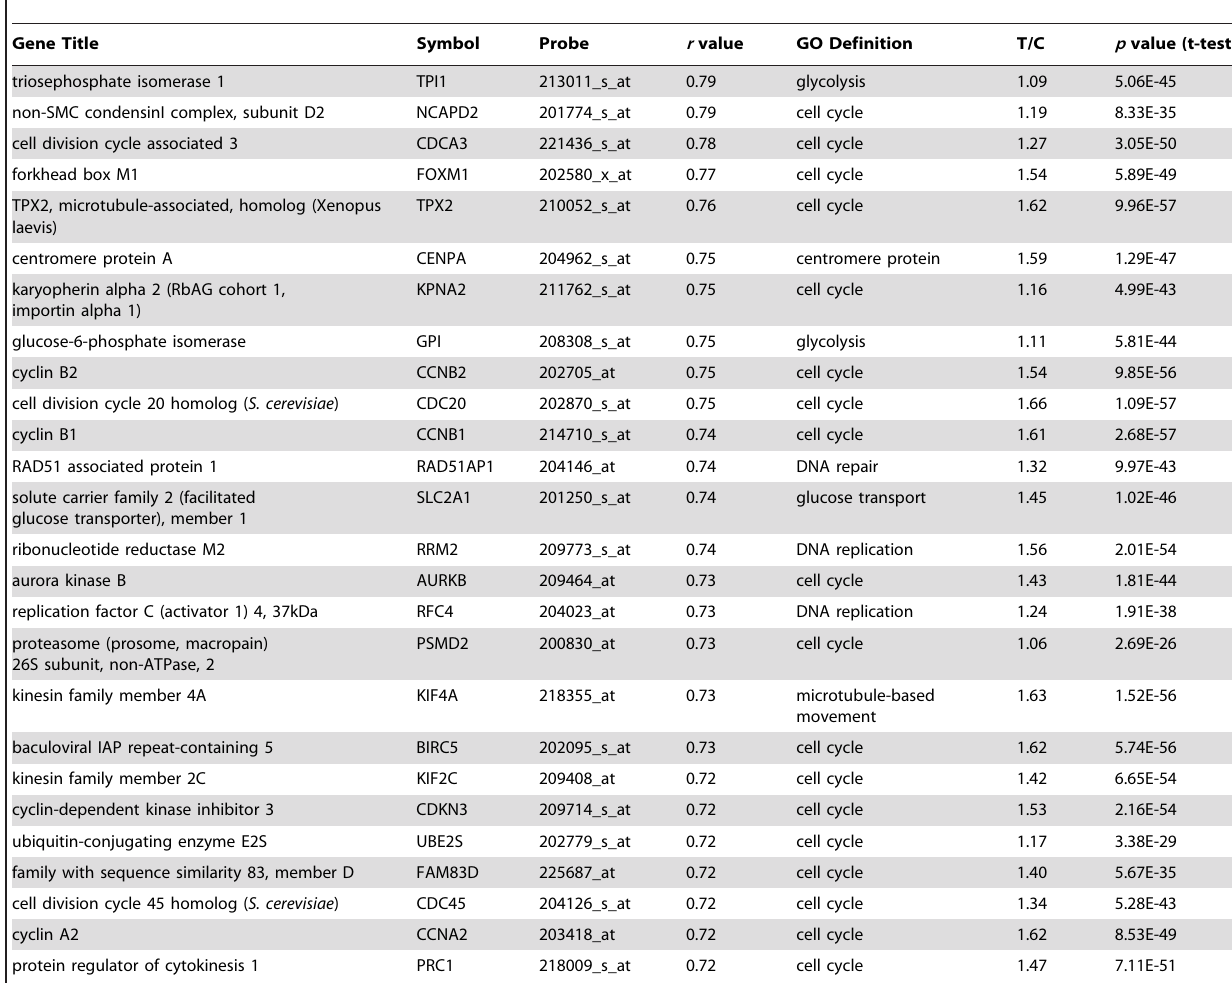
Table 1. Top ranked up-regulated GAPDH positively associated genes in NSCLC (correlation coefficient greater than or equal to